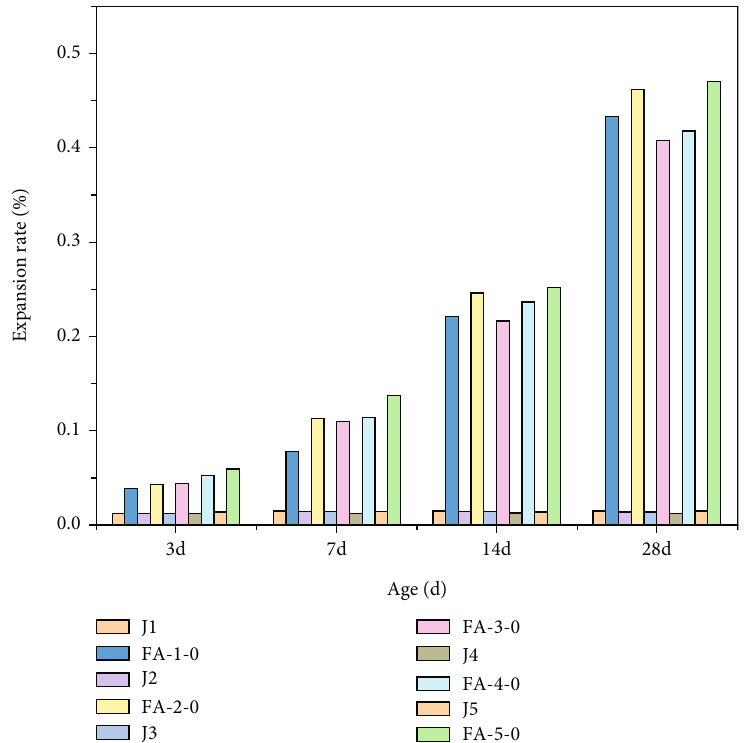
Figure 3: A graph of the expansion rate and age of the reference specimen.